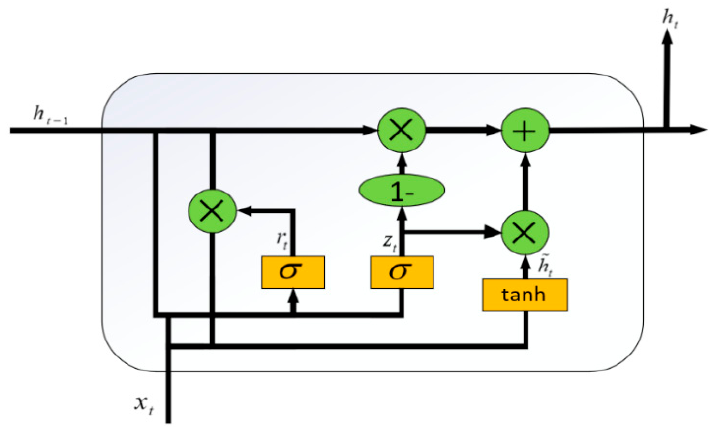
Figure 3. Cell structure of GRU.